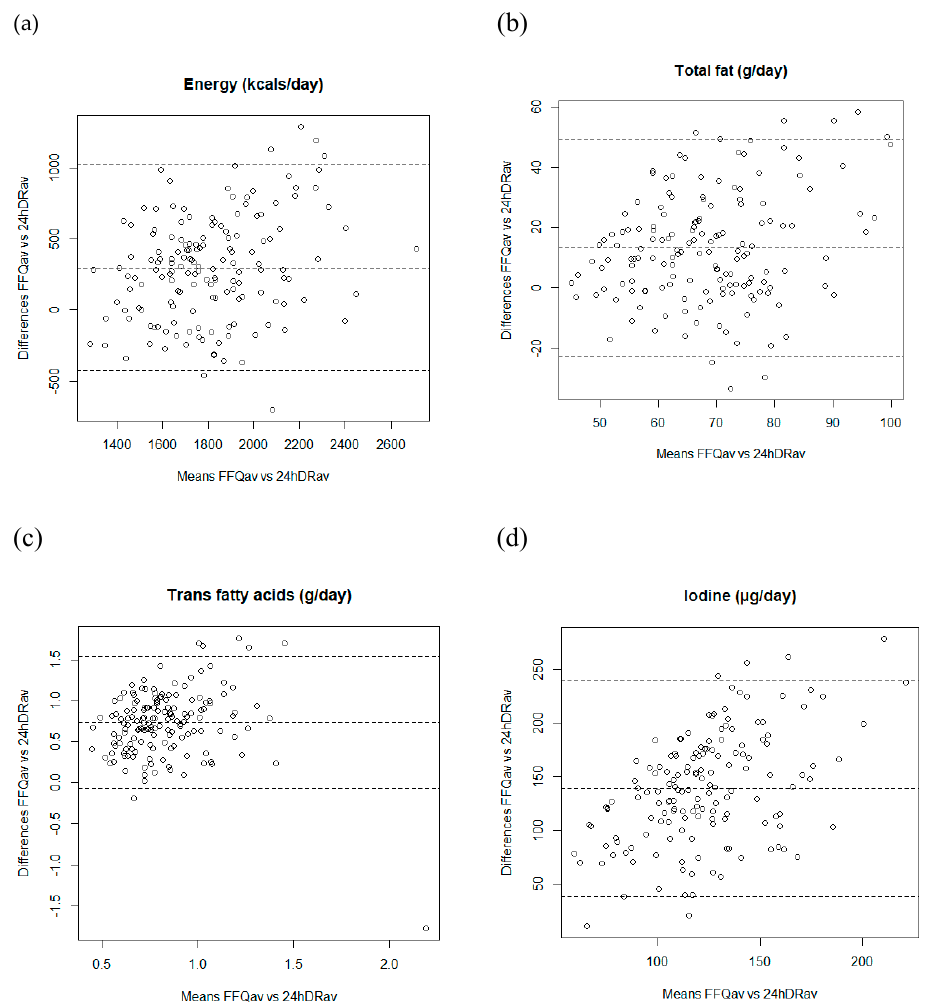
Figure 2. Bland-Altman plots showing the relationship between mean and di ff erences in the daily intake of ( a ) energy; ( b ) total fat; ( c ) trans fatty acids, and ( d ) iodine estimated with the mean of two FFQ and three 24hDRs. Table 6. Mean daily vitamin intakes Pearson correlation coe ffi cients from the first FFQ and